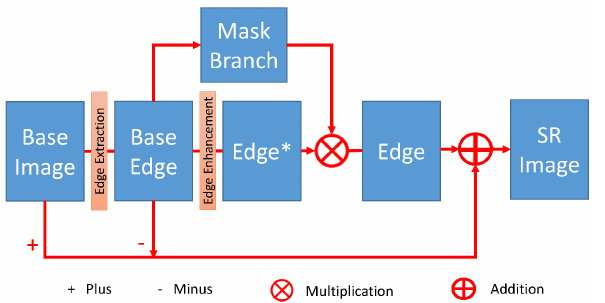
Figure 5. Edge extraction and enhancement, where Edge* represents the image after edge